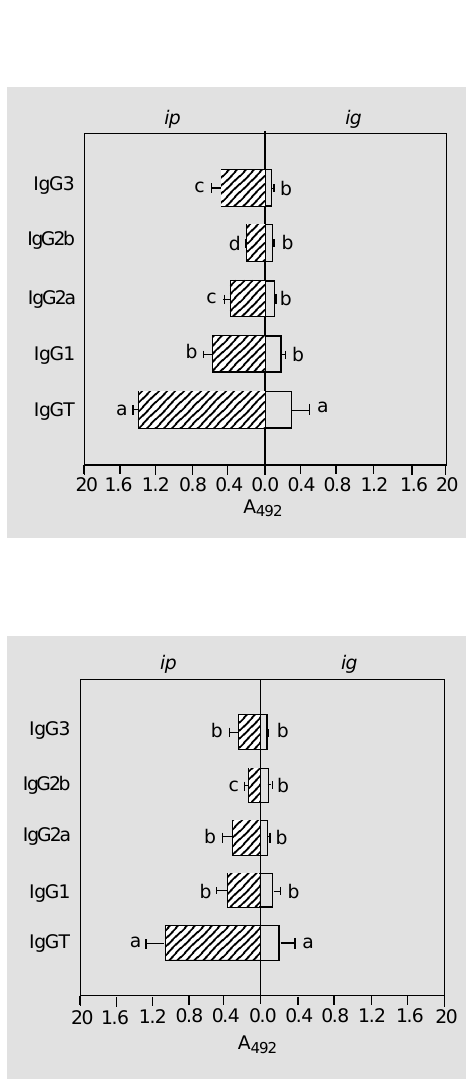
Figure 2 - Subclasses of serum anti-pCry1Ac IgG antibodies in- duced after ip or ig immuniza- tion with 100 µg of pCry1Ac. Nonimmunized mice showed serum antibody log-titers <1. Bars represent the mean ± SD titers for each experimental group (N = 5). The letters on top of the bars represent the differ- ences observed by the New- man-Keuls test (P<0.01).